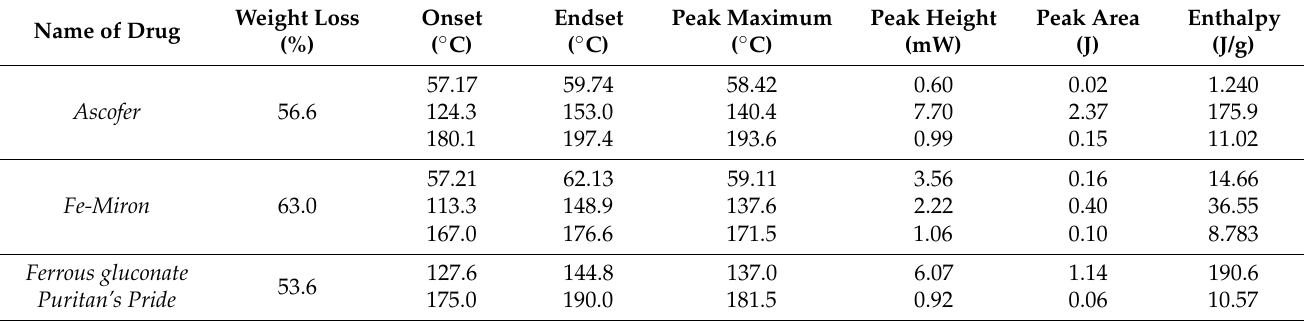
Table 6. Parameters determined from TG and DSC analysis for drugs containing. iron (II) gluconate.